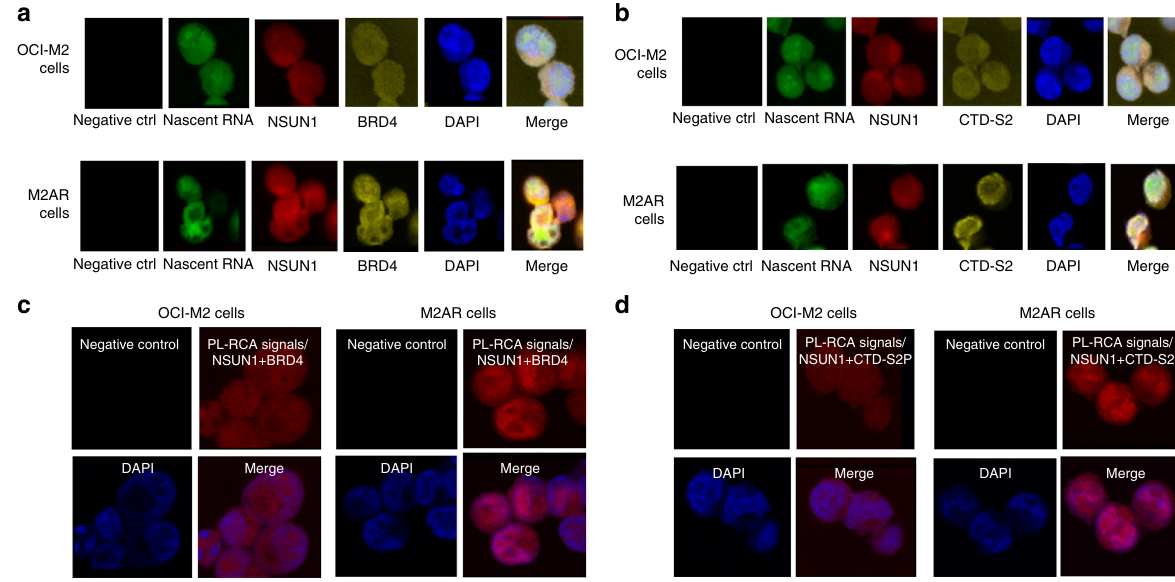
Fig. 7 Distinct NSUN1/BRD4-associated active chromatin structures in 5-AZA-restsant leukaemia cells. a Elucidation of the subcellular localization of nascent RNA, NSUN1 and BRD4 by 5-ethynyluridine (EU)-clicking chemistry-coupled STED confocal microscopy in OCI-M2 and M2AR cells with 0.3 M M EU for 5 h. b Elucidation of the subcellular localization of nascent RNA, NSUN1 and RNA-pol-II CTD-S2P by EU-clicking chemistry-coupled STED confocal microscopy in OCI-M2 and M2AR leukaemia cells treated with 0.3 mM EU for 5 h. c Demonstration of markedly increased co-localization of NSUN1 and BRD4 by proximity ligation and rolling circle ampli fi cation (PL-RCA) in OCI-M2 and M2AR cells. d Demonstration of markedly increased co-localization of NSUN1 and RNA-pol-II CTD-S2P by proximity ligation and rolling circle ampli fi cation (PL-RCA) in OCI-M2 and M2AR